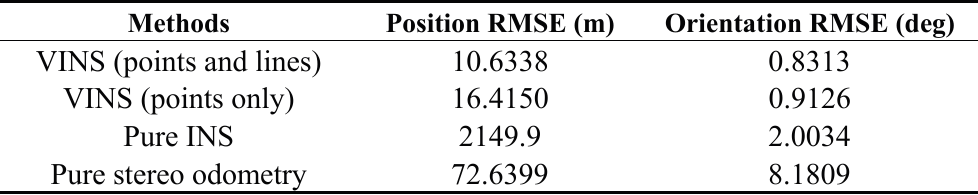
Figure 4. 3D Position Errors of different solutions. Table 1. The overall RMSE of the outdoor experiment.